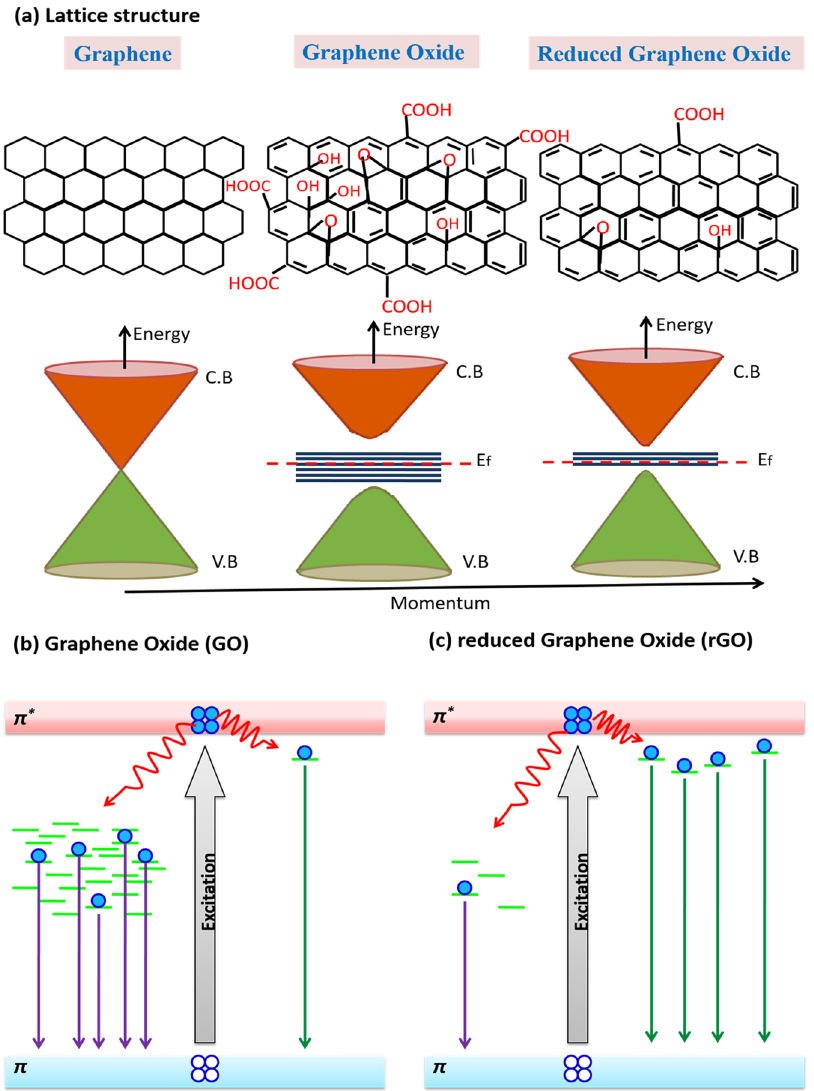
Figure 1. Schematic representation of: ( a ) Lattice structure and corresponding energy band diagrams of Graphene, GO and rGO; and electronic transitions in ( b ) GO and ( c )